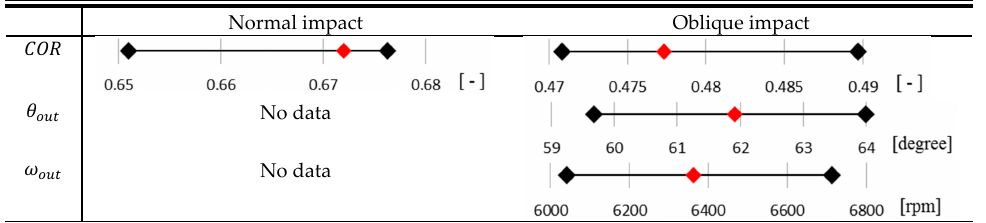
analysis. The red and black markers represent the results of the FE analysis and the range of the experimental results, respectively. ( 𝐶𝑂𝑅 = 𝑣 (cid:3042)(cid:3048)(cid:3047) 𝑣 (cid:3036)(cid:3041)